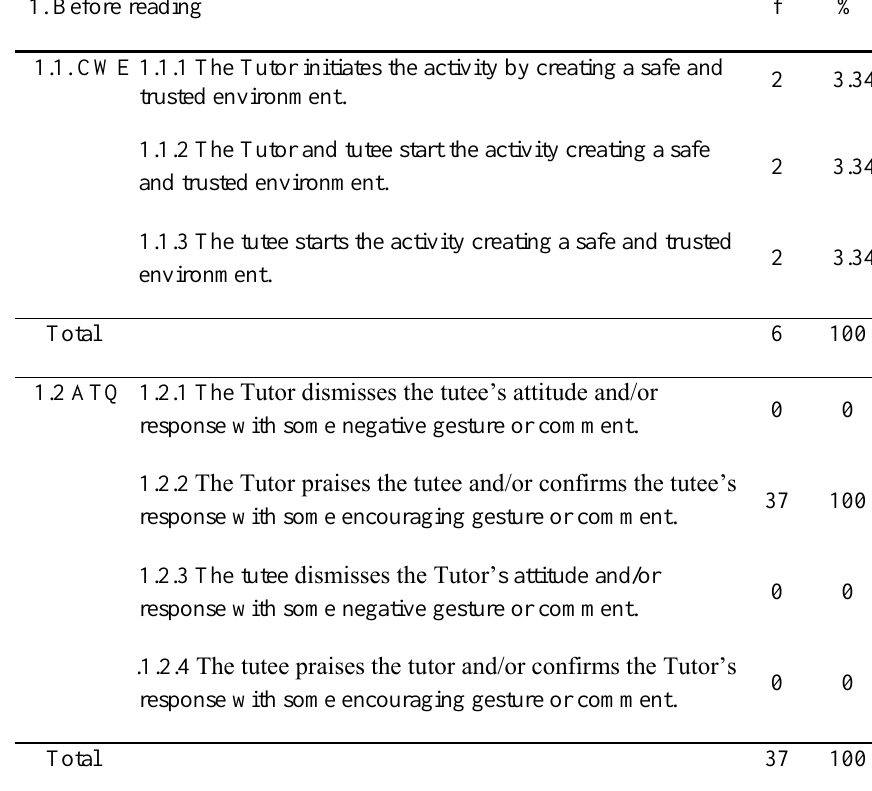
Distribution of frequency according to dimensions and categories in segment 1. Before